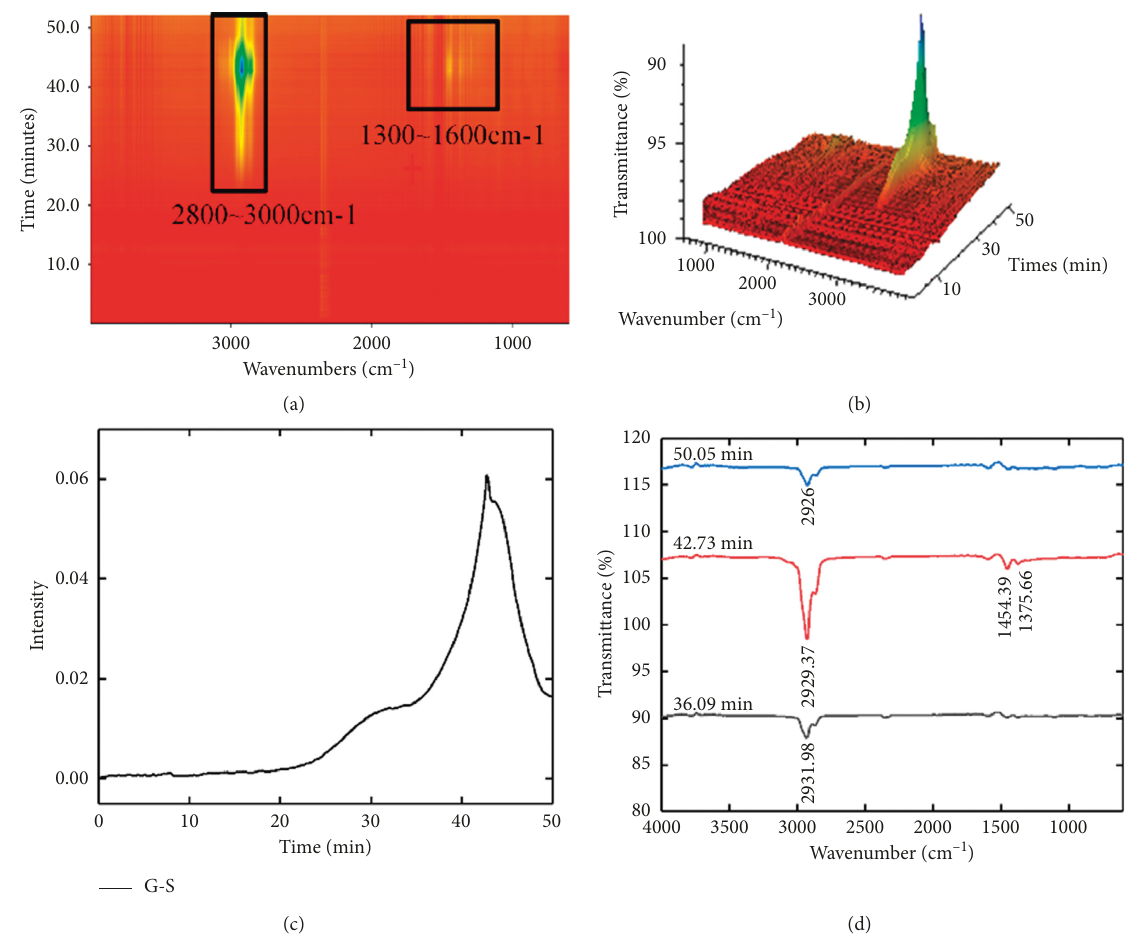
Figure 8: Dynamic-FTIR analysis results of T770. (a) 2D. (b) 3D. (c) GS. (d)